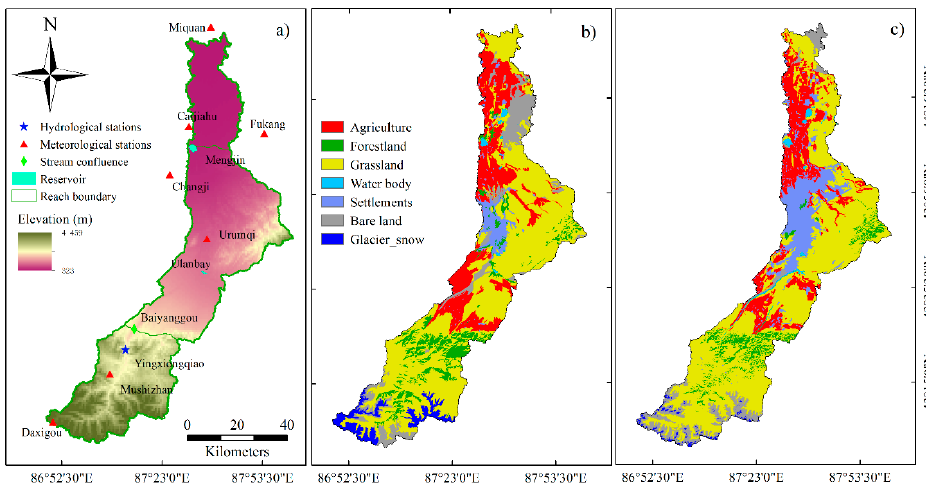
Figure 1. ( a ) Location of the Urumqi River basin and spatial layout of land surface condition in ( b ) 1980 and ( c ) 2015.